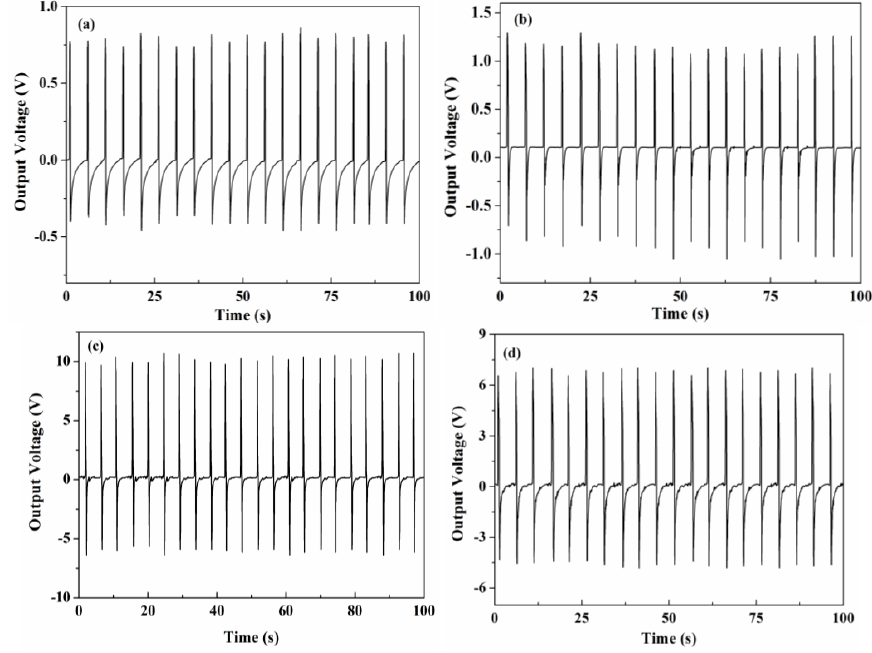
Figure 4. Voltage generation under a periodic mechanical tapping. ( a ) Pure PVDF; ( b ) 10 wt % PMN-PT; ( c ) 20 wt % PMN-PT; and ( d ) 25 wt % PMN-PT.